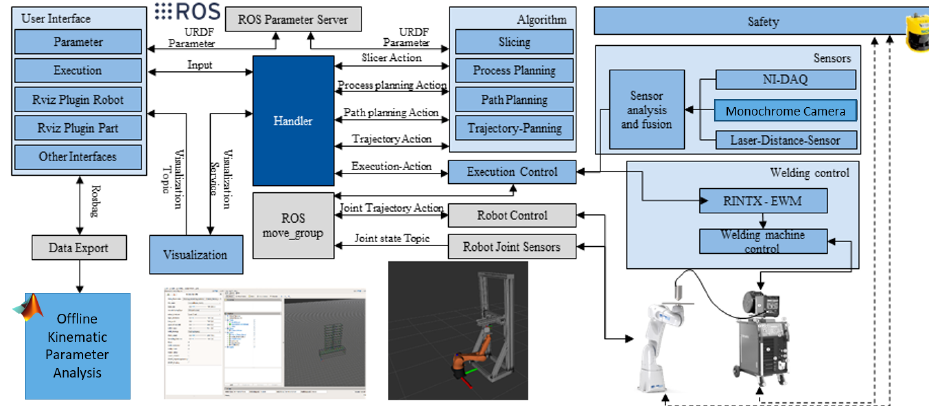
Figure 5. Hardware Interface of the Multidirectional Additive Manufacturing.